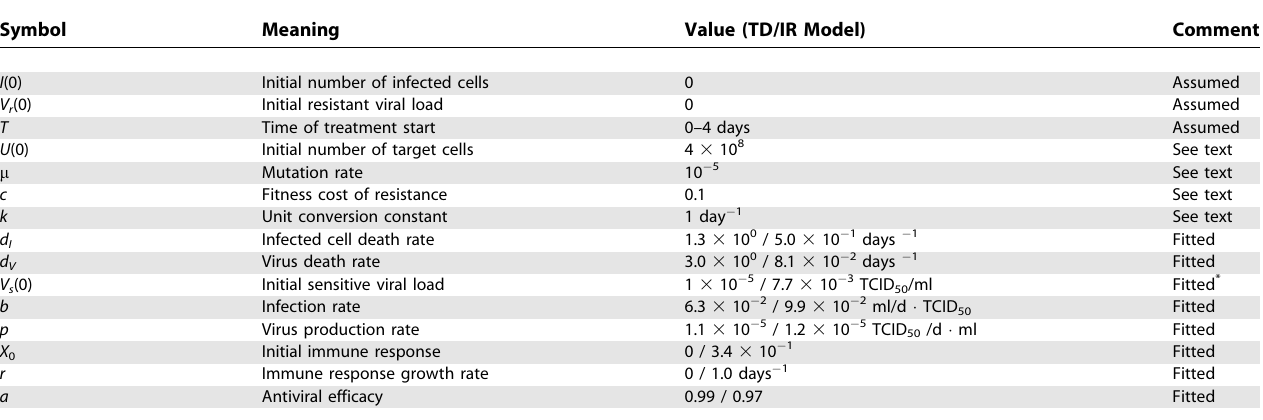
Table 2. Parameters for the Two Models Describing the within-Host Dynamics